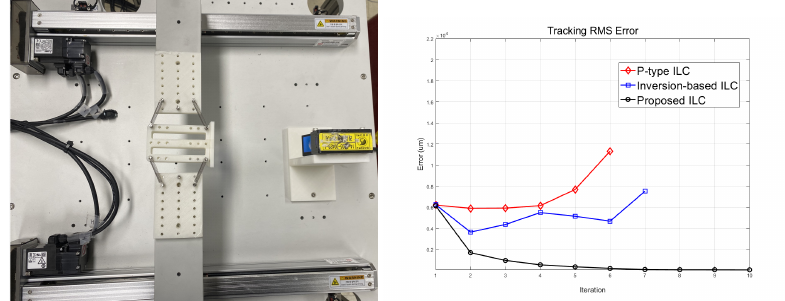
Figure 11. Modified connecting bridge for low